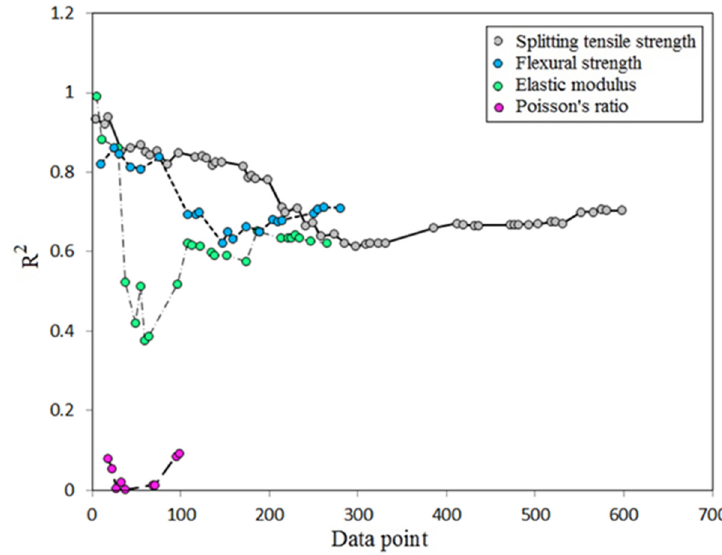
Figure 5. Variation of coefficient of determination for different properties.